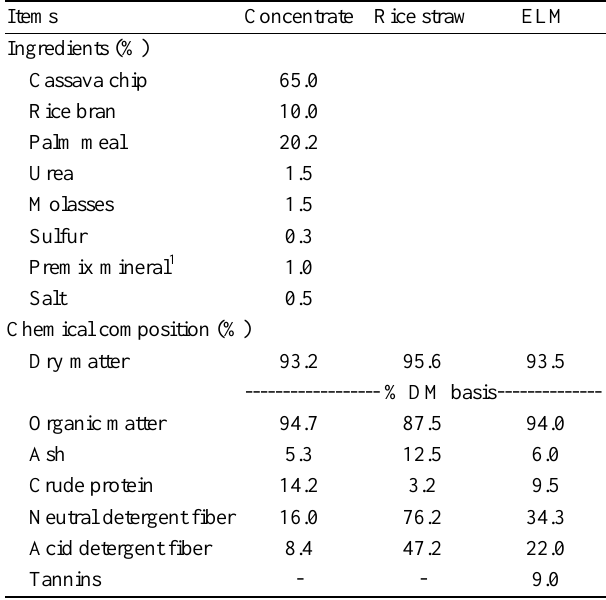
Table 1. Ingredients and chemical composition of experimental